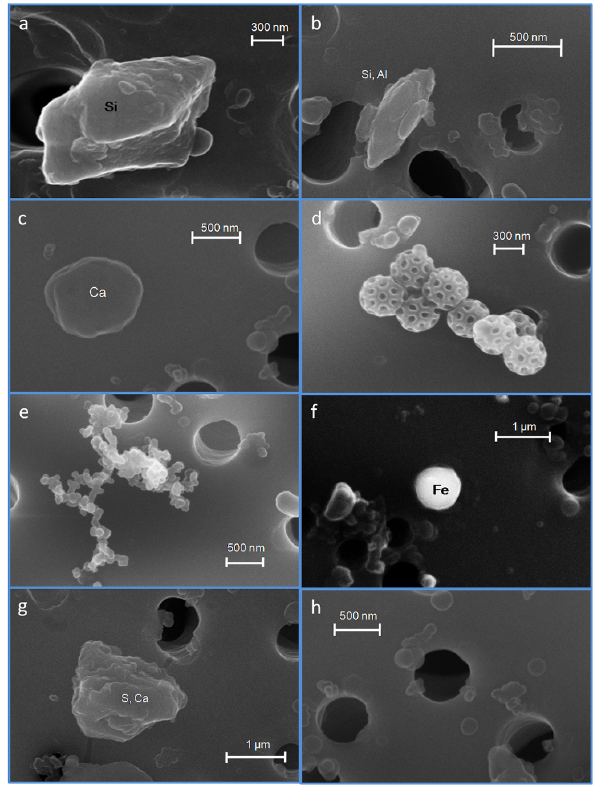
Figure 4. SEM images of each main typology of particles iden- tified: (a) silica particle (quartz); (b) aluminosilicate (kaolinite); (c) carbonate particle (calcite); (d) biogenic particle (brocosomes); (e) non-biogenic C-rich particle (soot); (f) metal particle (iron ox- ide); (g) S-rich particle (gypsum); (h) secondary low-Z element par- ticles.